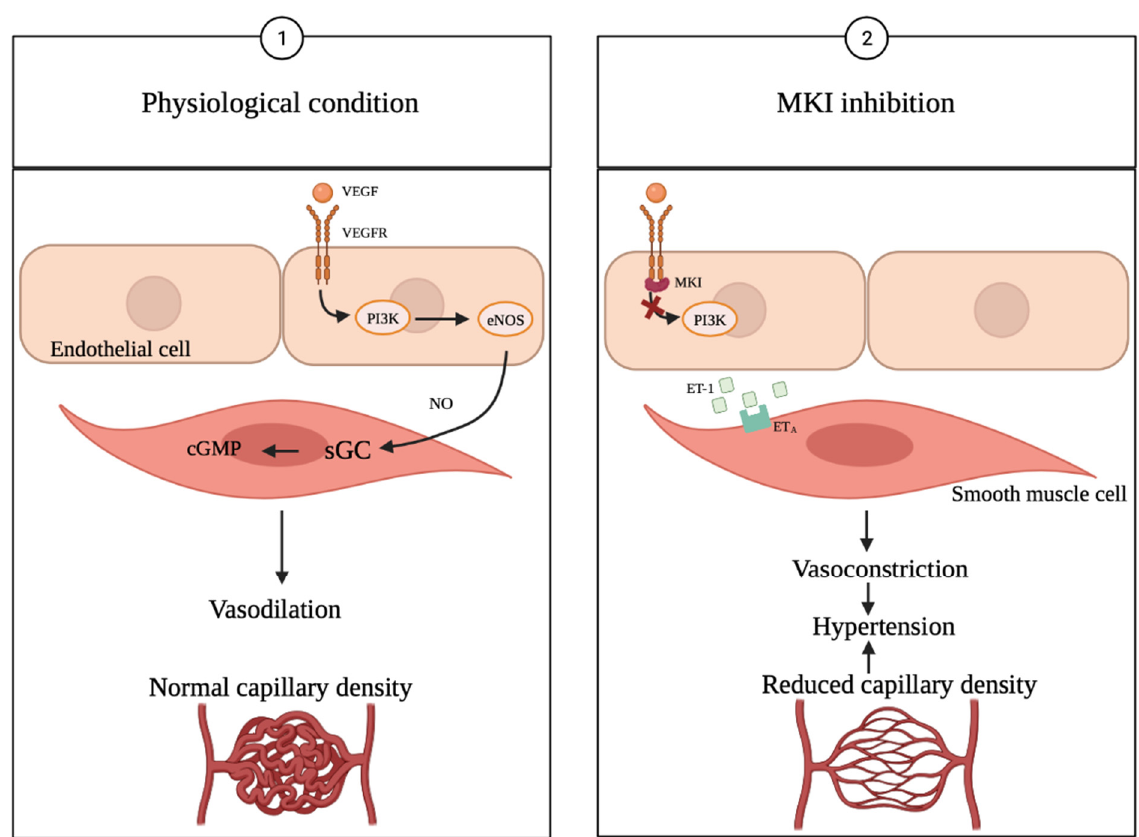
Figure 2. MKI treatment induced hypertension. Inhibition of VEFGR causes hypertension, as VEGFR receptors are present on both healthy vascular endothelial cells and in cancer cells, causing the MKI treatment to also affect healthy endothelial cells [18] (adapted from [18,75]). NO production is inhibited, and the endothelin-1 pathway is activated leading to vasoconstriction. VEGF is important for the integrity of the capillary network and inhibition of the VEGFR leads to reduction in capillary density [75]. VEGF (vascular endothelial growth factor), VEGFR (vascular endothelial growth factor receptor), PI3K (phosphatidylinositol-3-kinase), eNOS (endothelial nitric oxide), sGC (soluble guanylate cyclase), cGMP (cyclic guanosine monophosphate), ET-1 (endothelin-1), E 𝑇 (cid:3002) (endothelin receptor type A) [18,75]. The figure was drawn using Biorender.com.